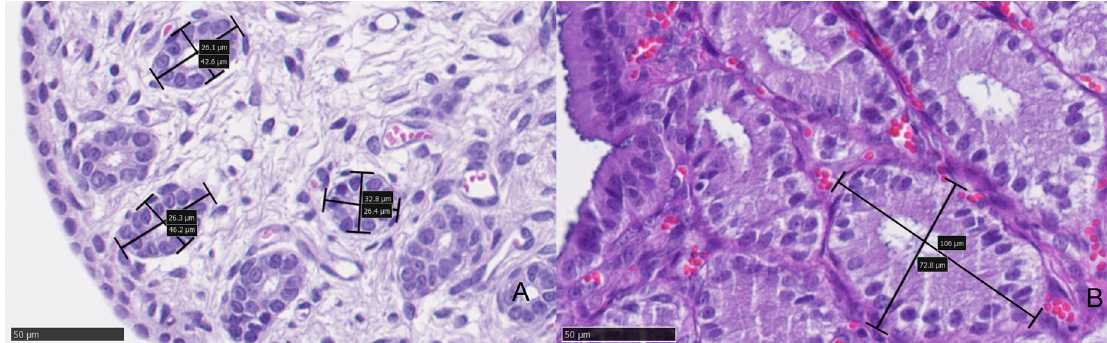
Figure 3. Glandular diameter in a queen’s endometrium. ( A ) Endometrial biopsy from a queen with low levels of serum progesterone (0.8 ng/mL). Black bars and boxes show the measures taken from the two perpendicular diameters of the gland (from the basal lamina to the opposite one), with a total mean of 33.5 mm in that queen. ( B ) Endometrial biopsy from a queen with high levels of serum progesterone (6.5 ng/mL). Black bars and boxes show the measures taken from the two perpendicular diameters of the gland (from the basal lamina to the opposite one), with a total mean of 98.99 mm in that animal. The glandular diameter values were significantly increased in animals with high levels of serum progesterone compared with the low progesterone